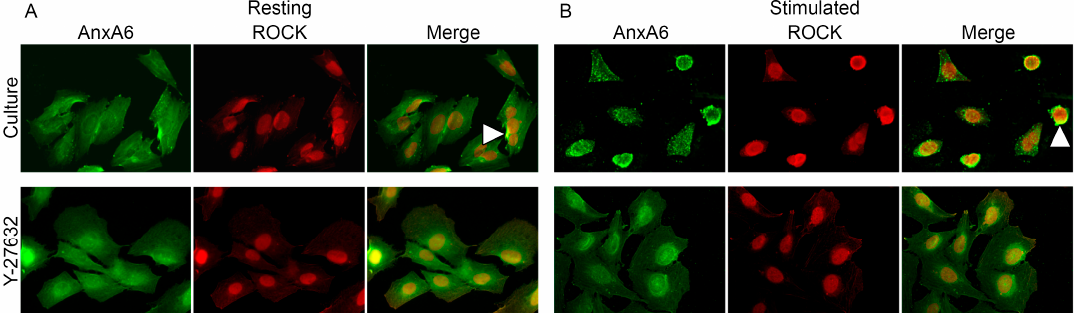
Figure 7. Co-localization of AnxA6 with ROCK in Saos-2 cells, non-treated or treated with different inhibitors, in resting conditions ( A ) or after seven-day stimulation with AA and β -GP ( B ). The cells were incubated with appropriate antibodies: mouse monoclonal anti-AnxA6 linked with goat-anti mouse IgG-FITC and rabbit polyclonal anti-ROCK 2 linked with goat anti-rabbit IgG-TRITC and observed under an Axio Observer Z1 fluorescent microscope (Carl Zeiss, Oberkochen, Germany) with phase contrast and appropriate fluorescent filters, magnification 240 × . The yellow color and arrowheads on the merge images indicate protein co-localization. Data of a typical experiment are